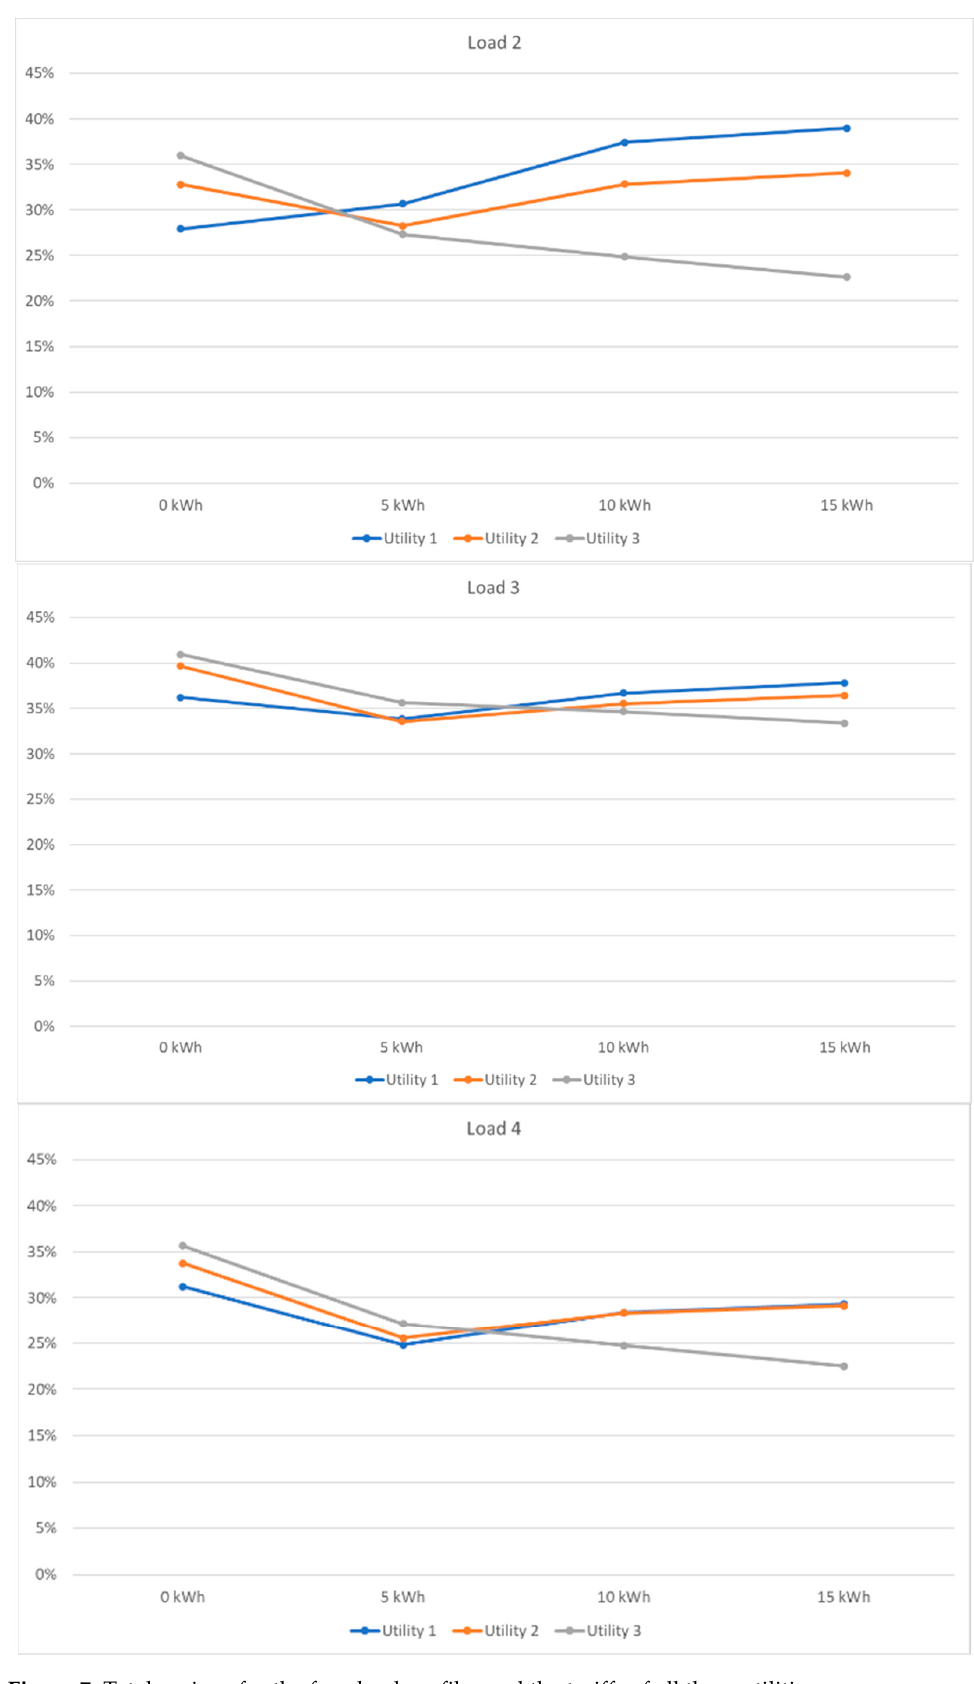
Figure 7. Total savings for the four load profiles and the tariffs of all three